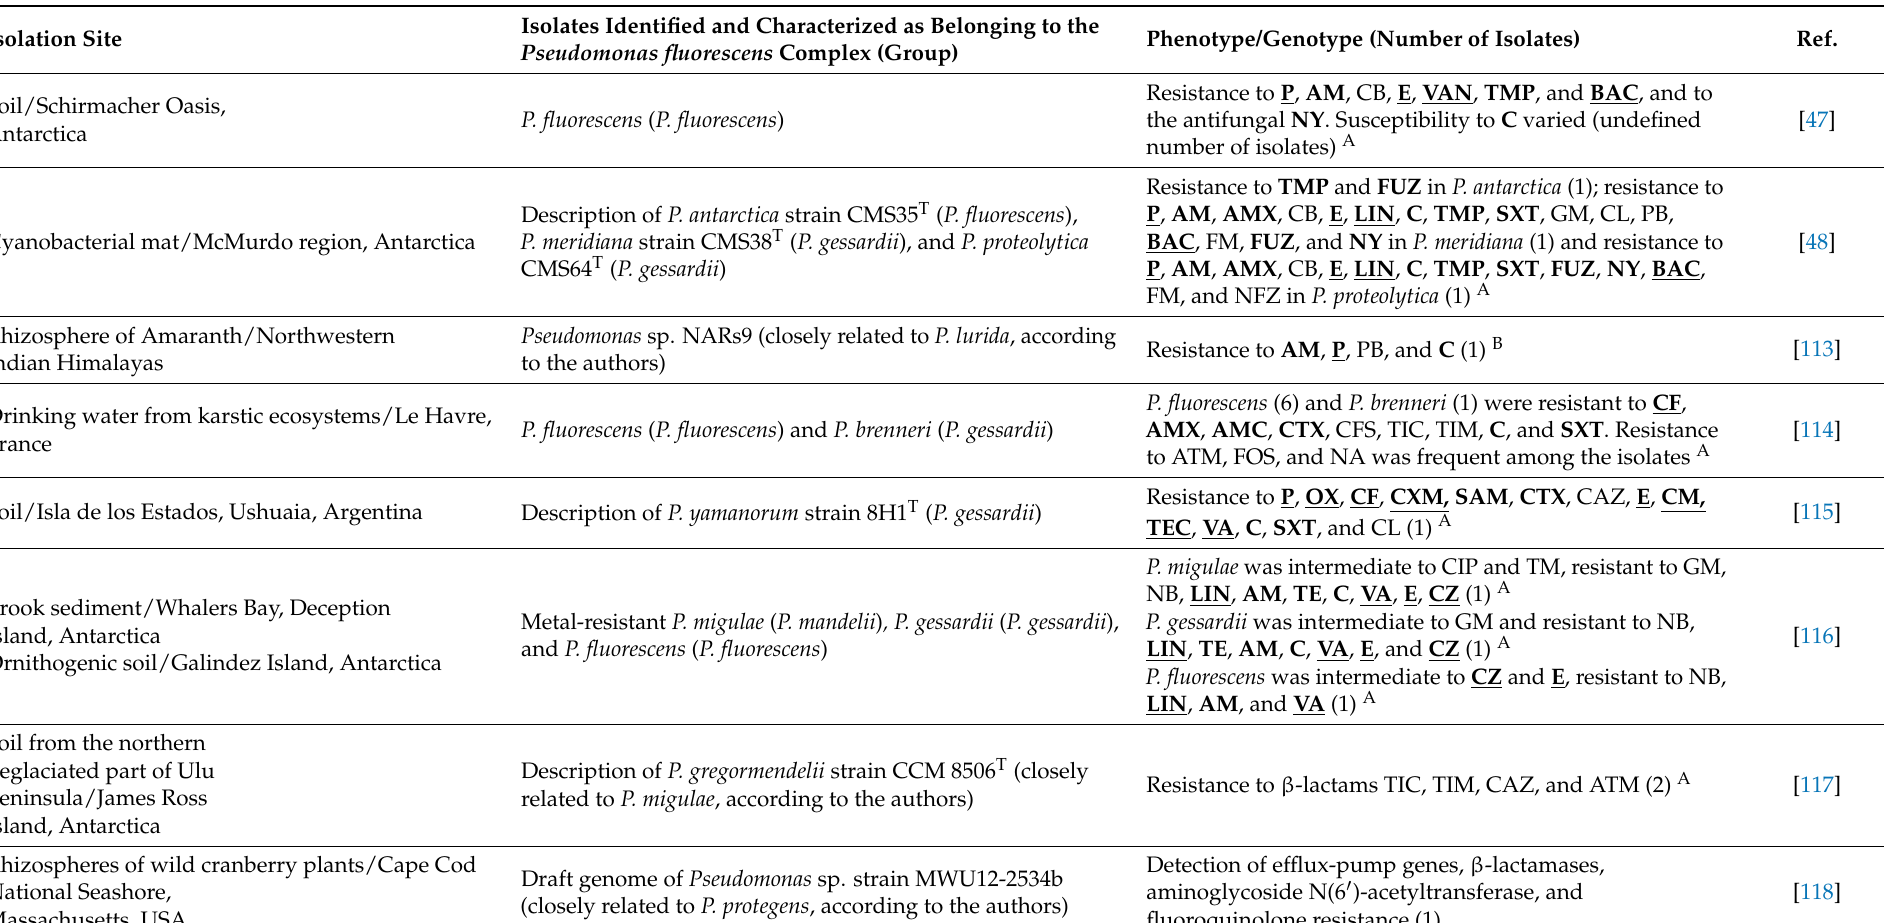
Table 1. Isolates of the Pseudomonas fluorescens complex obtained from pristine environments and their resistance